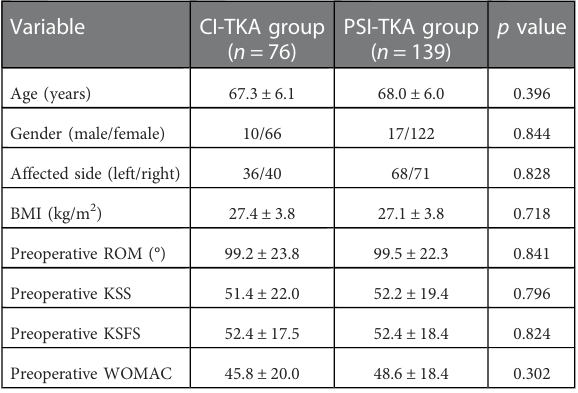
TABLE 1 Patients ’ demographics and clinical scores preoperatively.